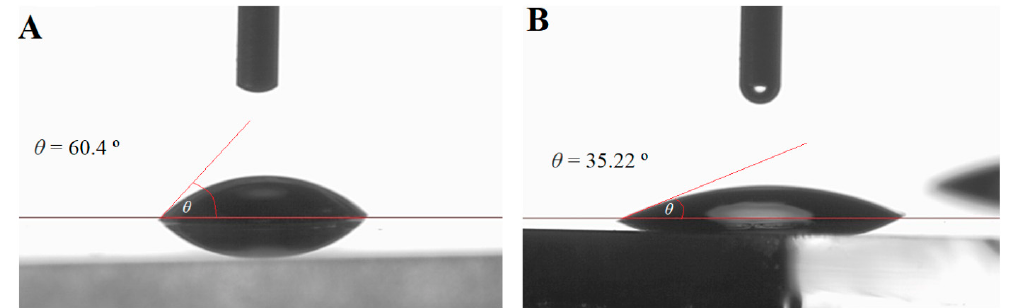
Figure 2. Surface hydrophilicity of investigated surfaces. ( A ) Behavior of a drop of water on the surface of a bare glass slide and ( B ) a Pt-coated glass